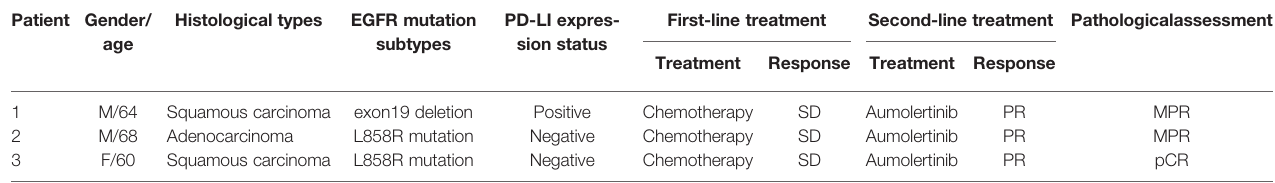
TABLE 1 | Patient characteristics and response to treatment before and after surgery (N =